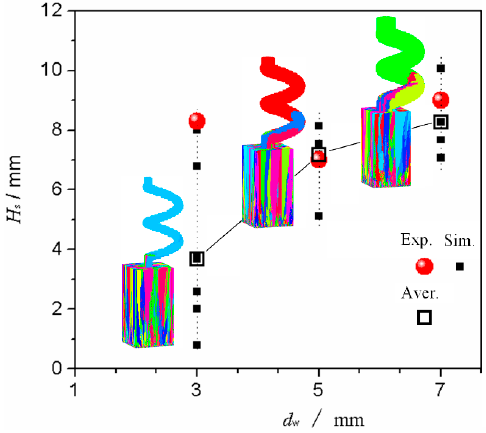
Figure 12. Comparison of H s in selectors with different d w , during experiment and simulation (5 trials) with h s = 14 mm and θ = 30°.